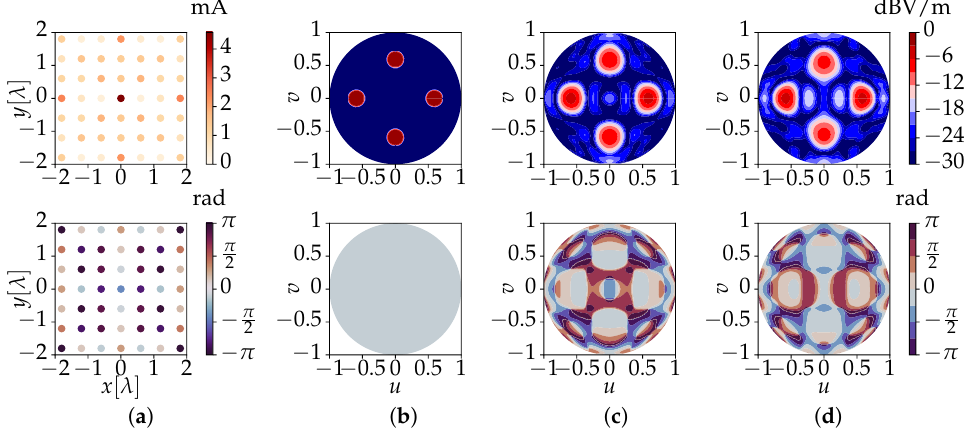
7 planar array consisting of 49 x -polarized dipoles. The figures show the Figure 8. Results for a 7 × amplitudes ( top ) and phases ( bottom ) of ( a ) the feeding currents obtained by the novel algorithm corresponding to ( b ) four separate focal spots. Further, we have ( c ) the co-polar electric field solutions obtained by the novel method and ( d ) the co-polar near-fields resulting from a full-wave simulation of the 7 7 array, excited by the currents in ( a ). The results are drawn for the upper hemisphere of a × target sphere of radius R T = 4 λ , where u = sin θ cos φ and v = sin θ sin φ